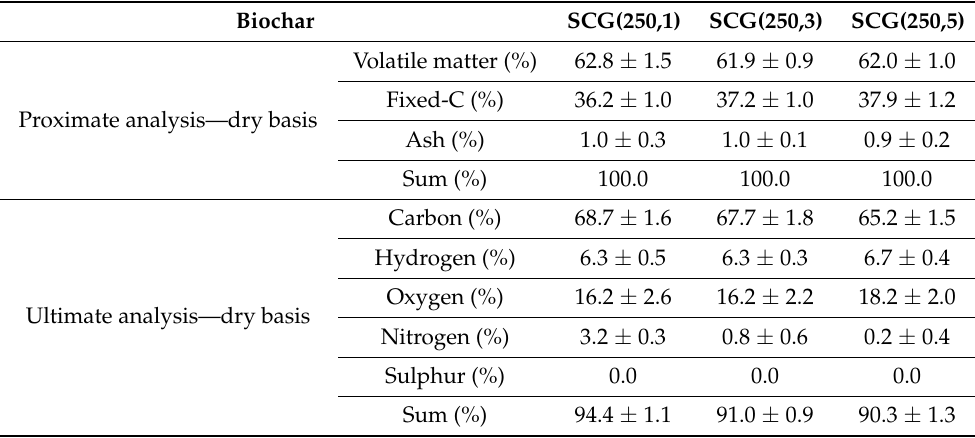
Table 4. Proximate and ultimate analysis of SCGs (spent coffee grounds) with different reaction times at 250 ◦